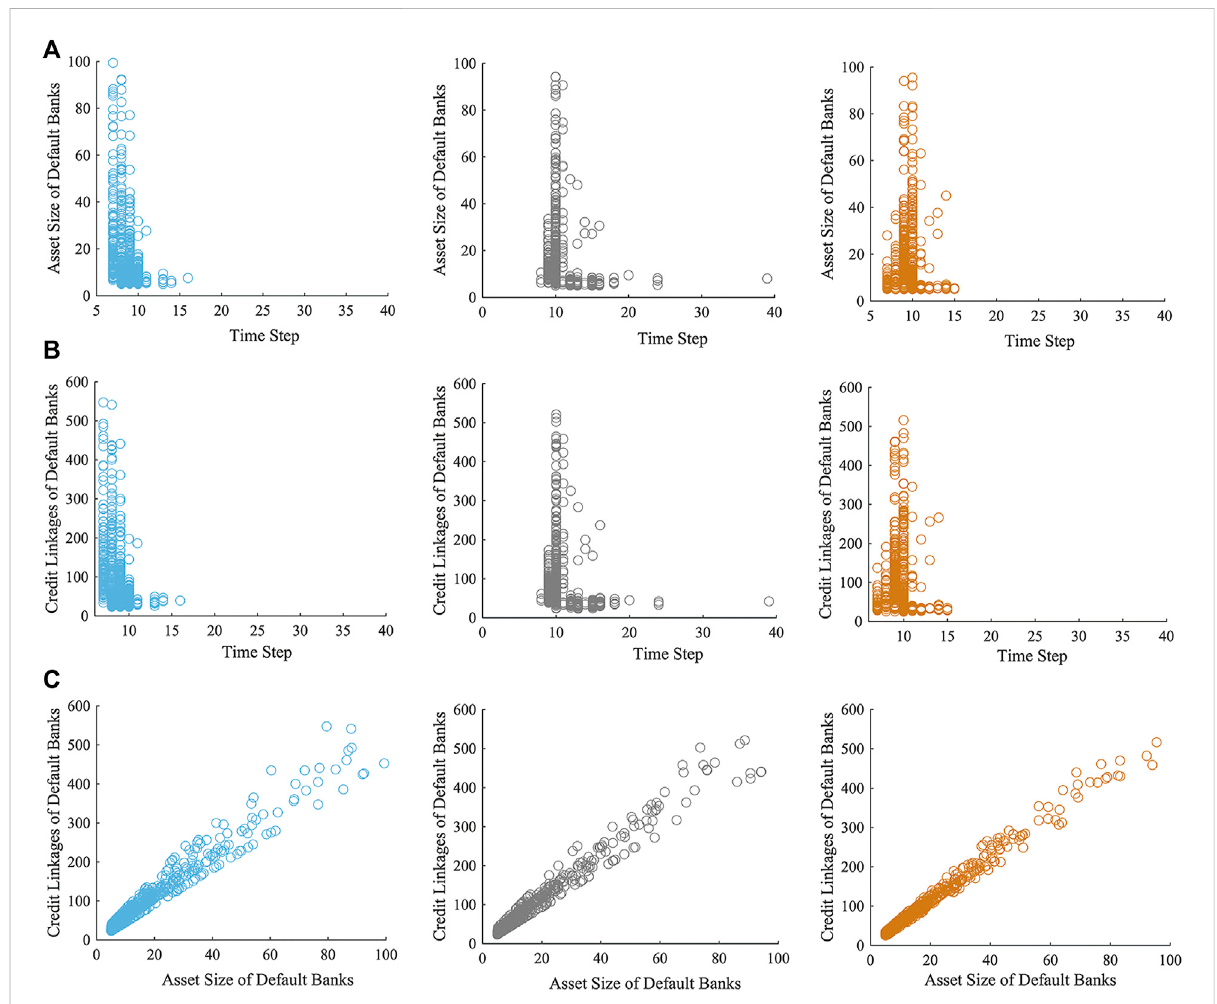
FIGURE 5 (A) Theassetsizeofeachdefaultbankandthetimestepofitsdefault; (B) Thecreditlinkagesofeachdefaultbankandthetimestepofitsdefault; (C) Scatter plot between the asset size and its credit linkages of each default bank. Blue, gray and orange represent macroeconomic fl uctuations in upward, downward and random trends, respectively.